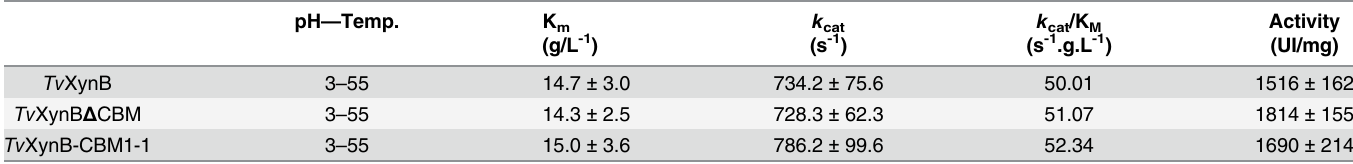
Table 3. Optimal reaction conditions and kinetic parameters of Tv XynB and mutants on BWX. pH —